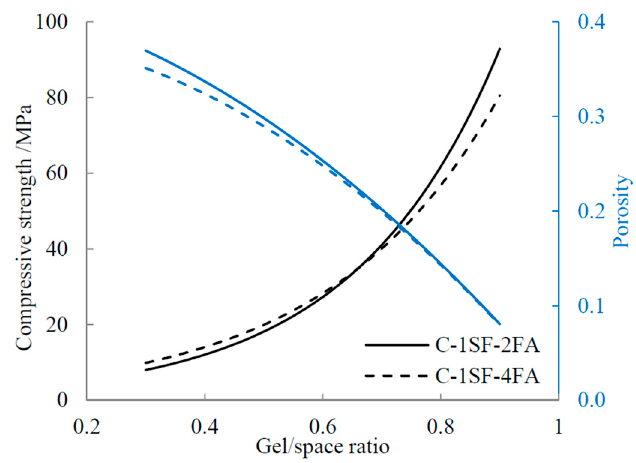
Figure 14. Influence of porosity on gel/space ratio.